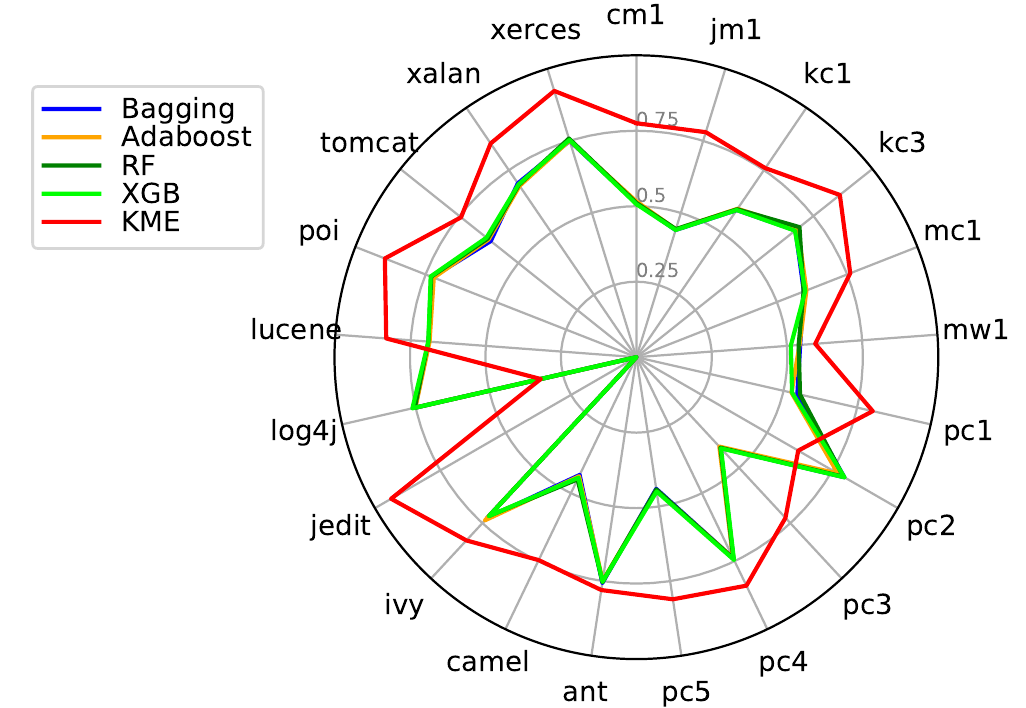
Figure 10. G-mean for the ensemble classifiers and KME.